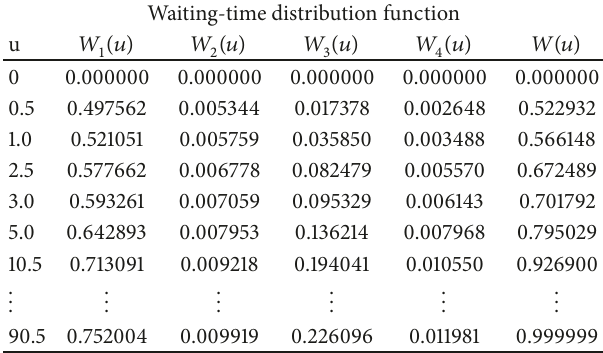
Figure 4: 𝑥 versus distribution function. Table 1: Actual waiting-time (in the system) distribution of a